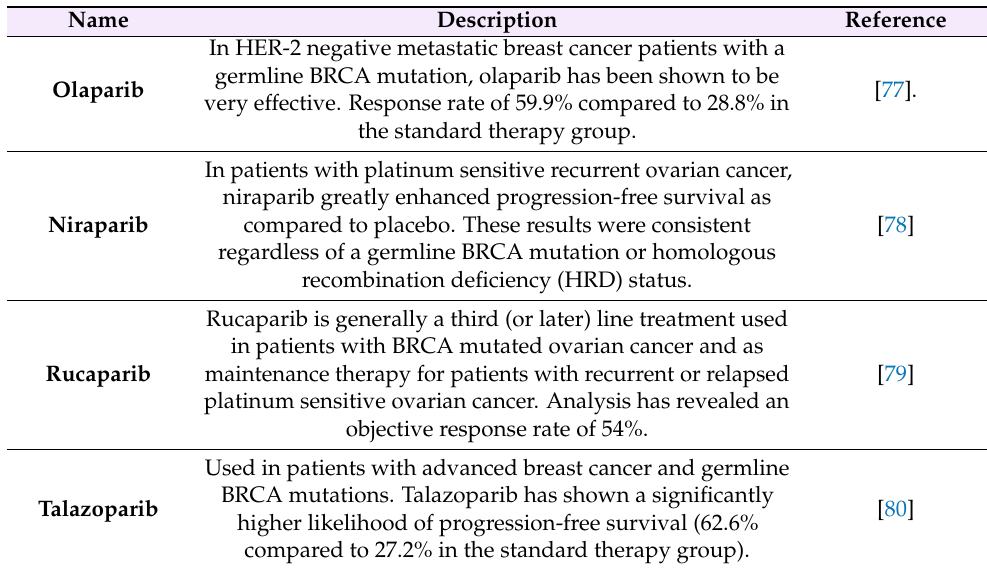
Table 1. PARP inhibitors and their clinical